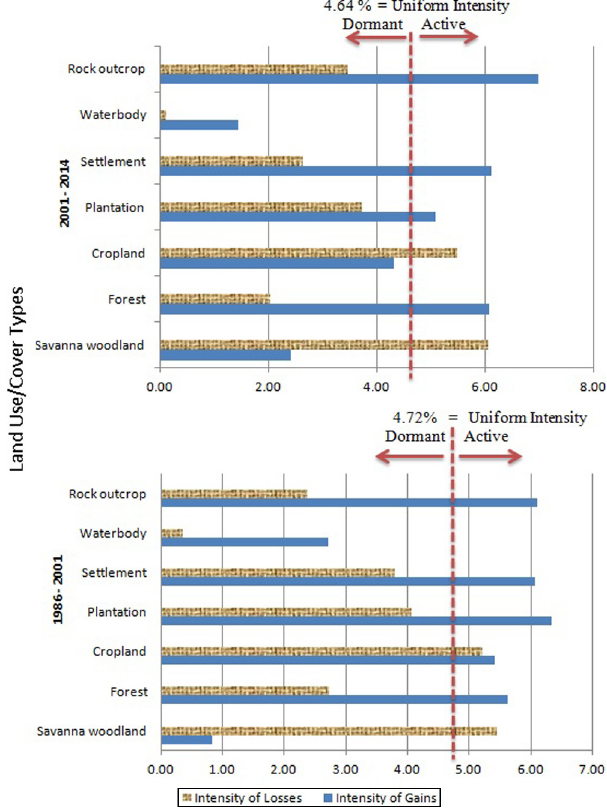
Figure 4. Category intensity change in two intervals (1986-2001 and